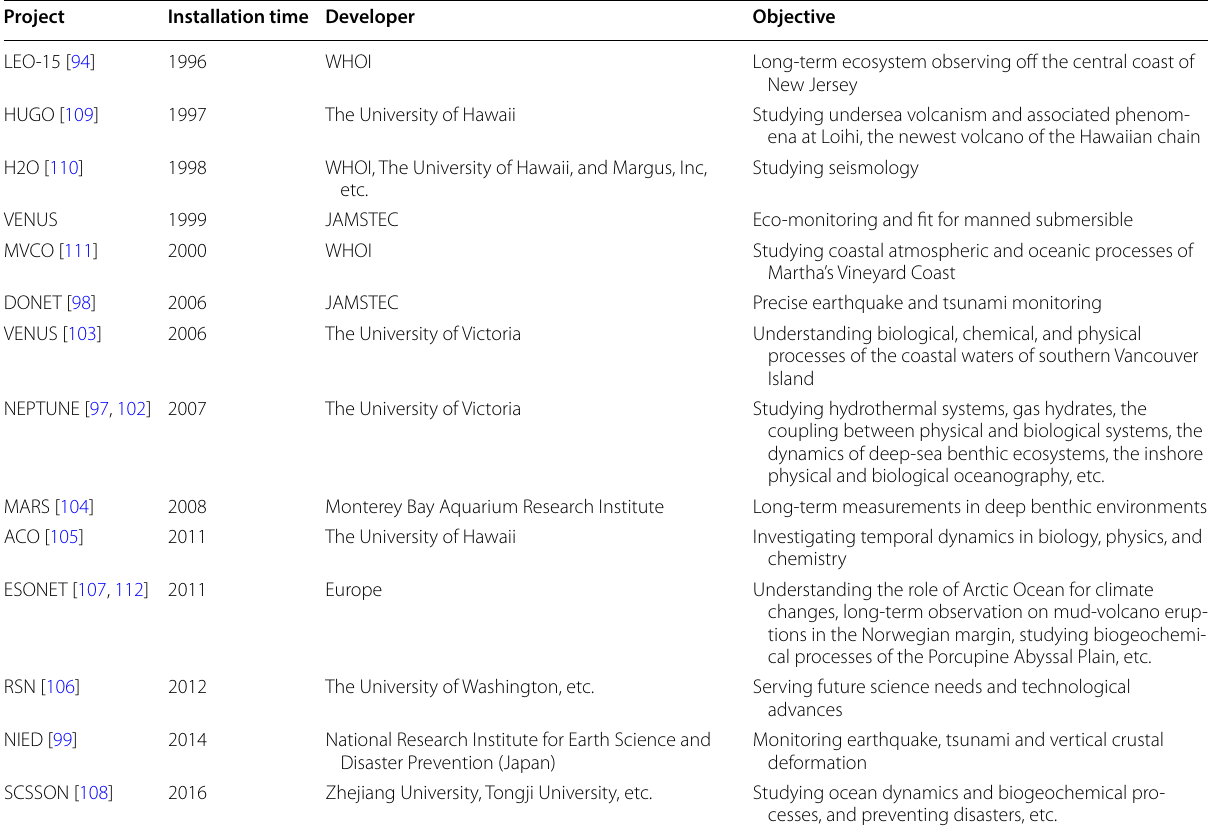
Table 3 Existing cabled seafloor observatories